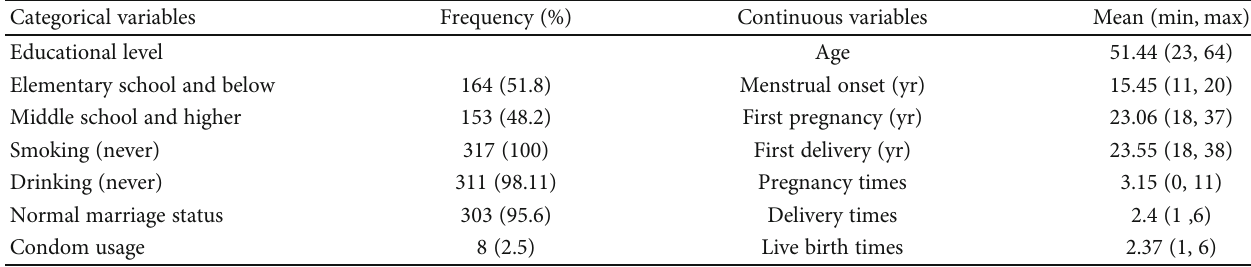
Table 1: Characteristics of the women with ASC-US cytology ( n = 317 ).